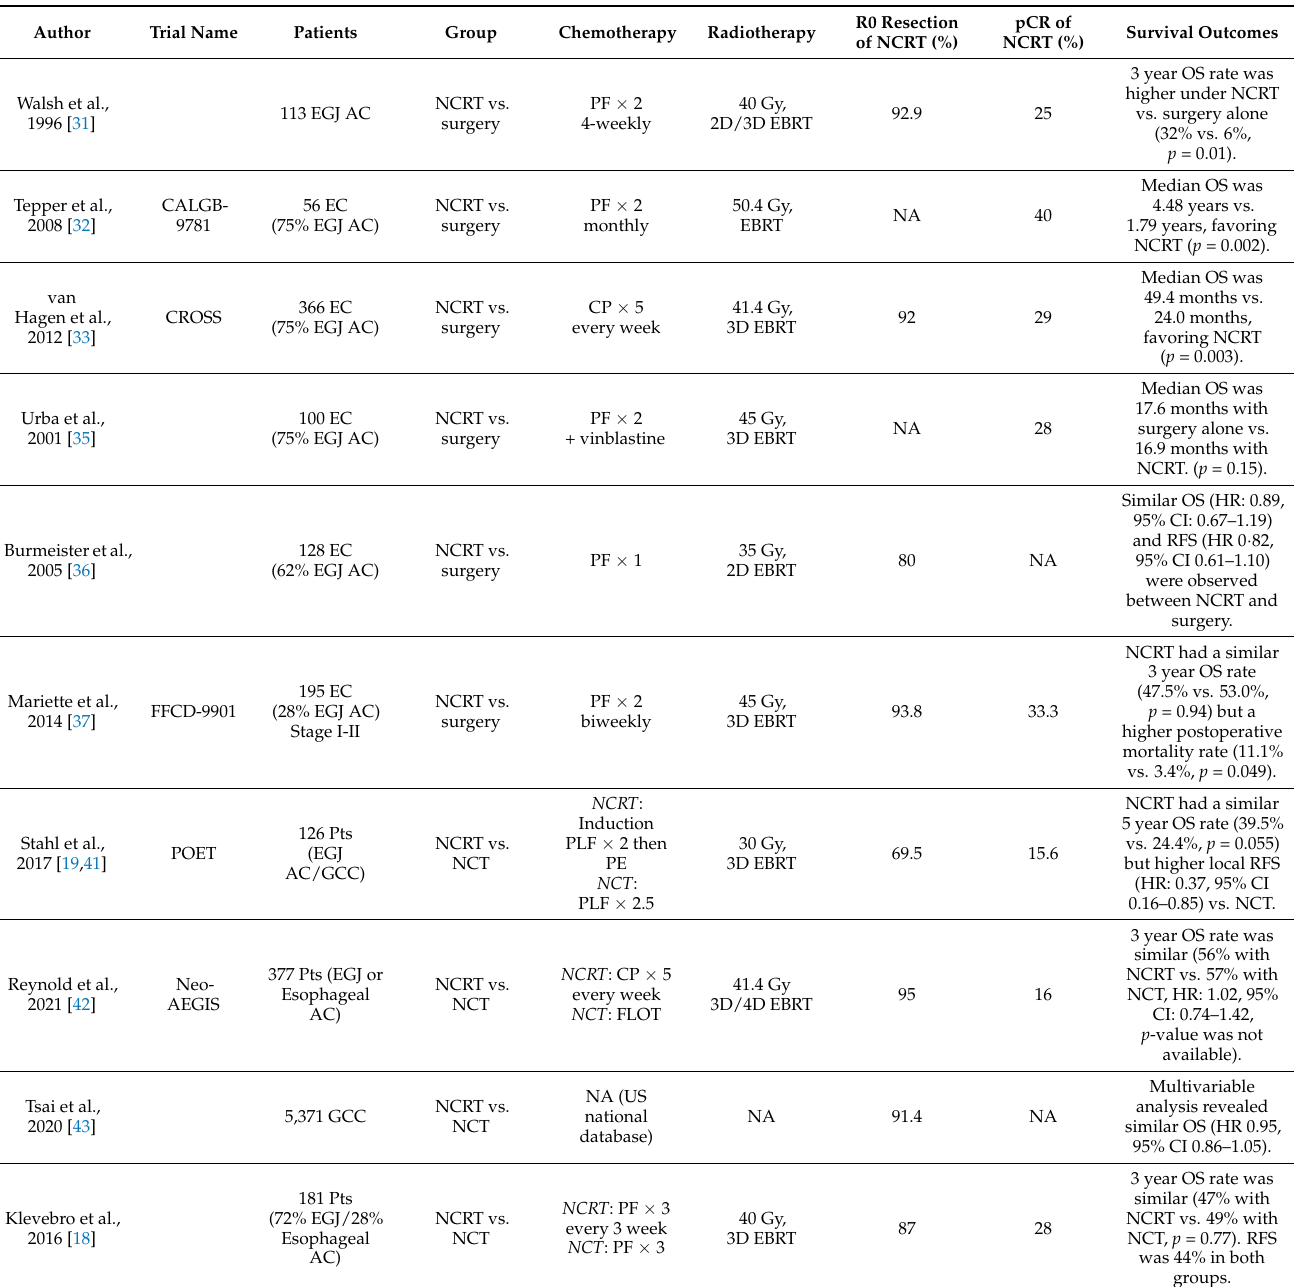
Table 1. Studies examining neoadjuvant chemoradiotherapy (NCRT) for esophagogastric junction (EGJ) cancer or gastric cardia cancer